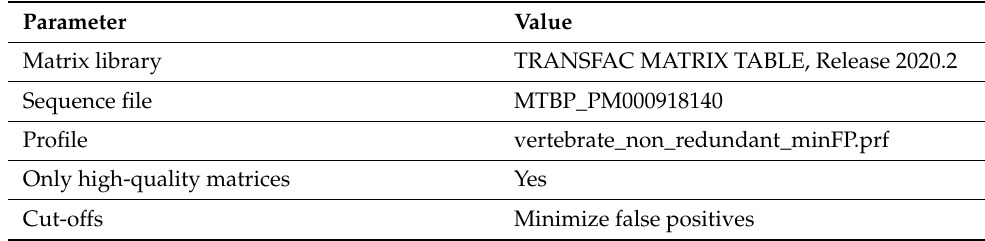
Table 2. Parameters used for TFBS